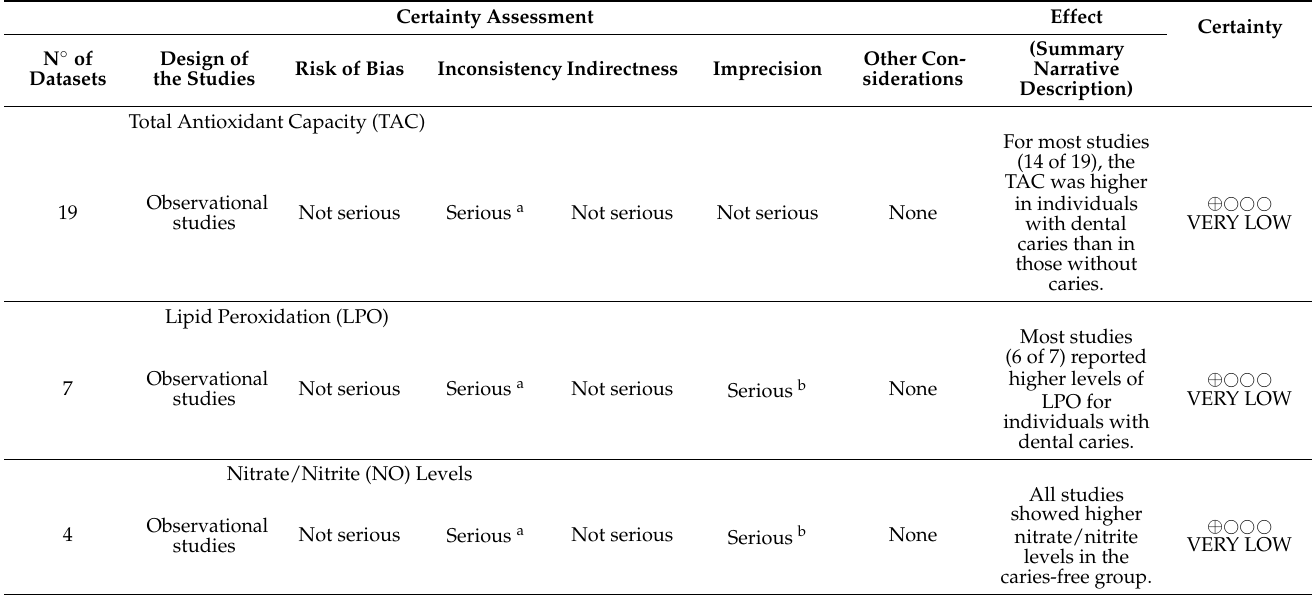
Table 4. Assessment of the certainty of